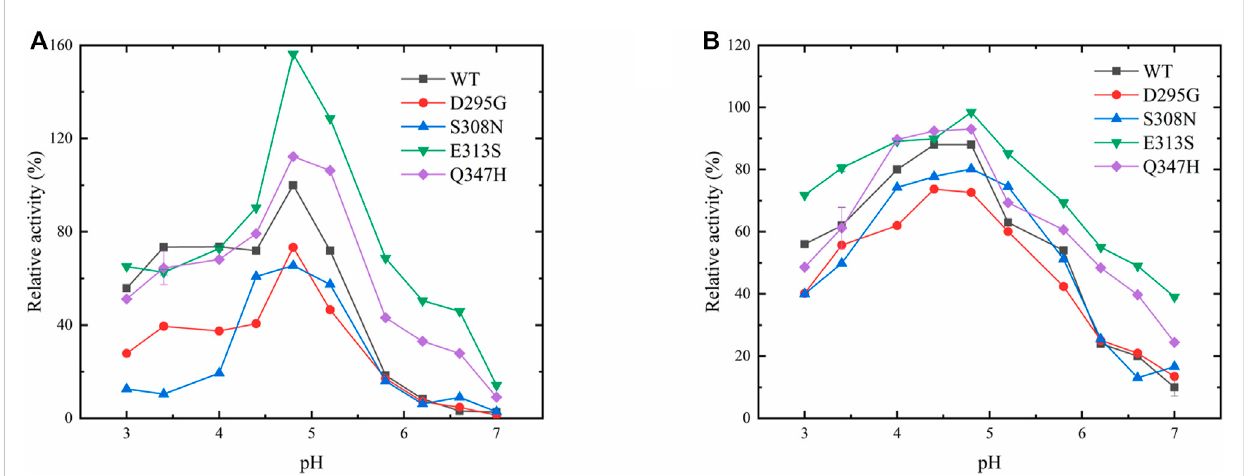
FIGURE 4 Effects of pH on the enzymatic activity of LpGAD and its variants. (A) Effect of pH on enzyme activity; (B) Effect of pH on enzyme